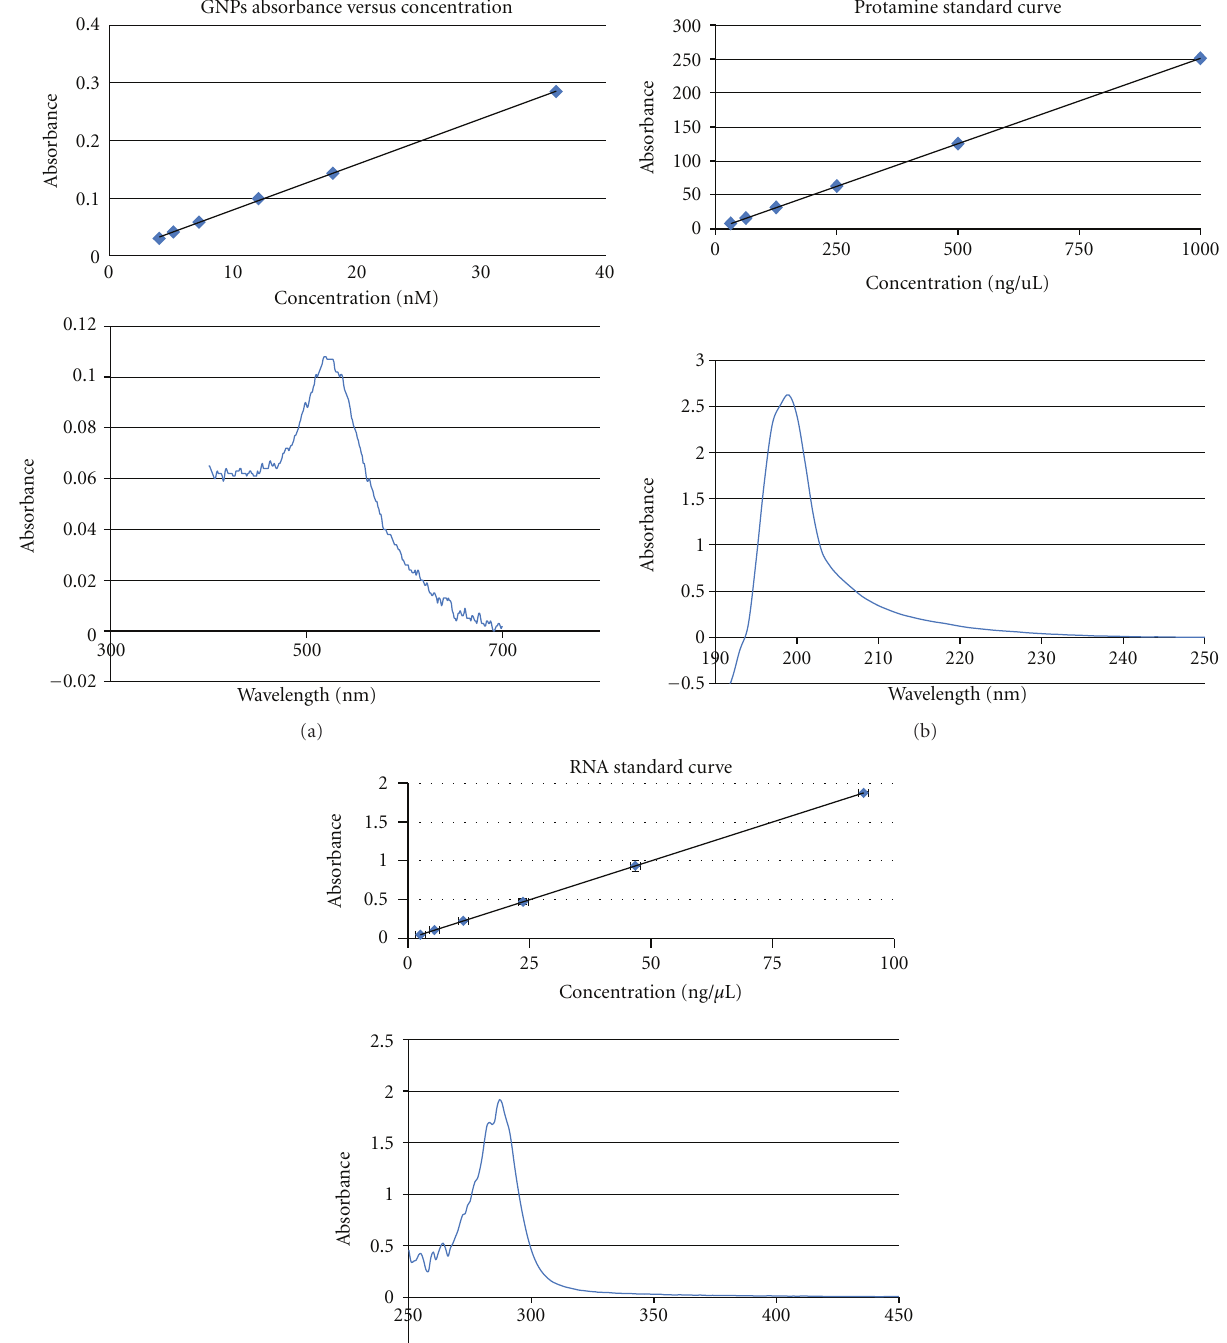
Figure 4: NanoDrop UV/Vis spectra (GNP, protamine, and RNA). Linear range in inset.